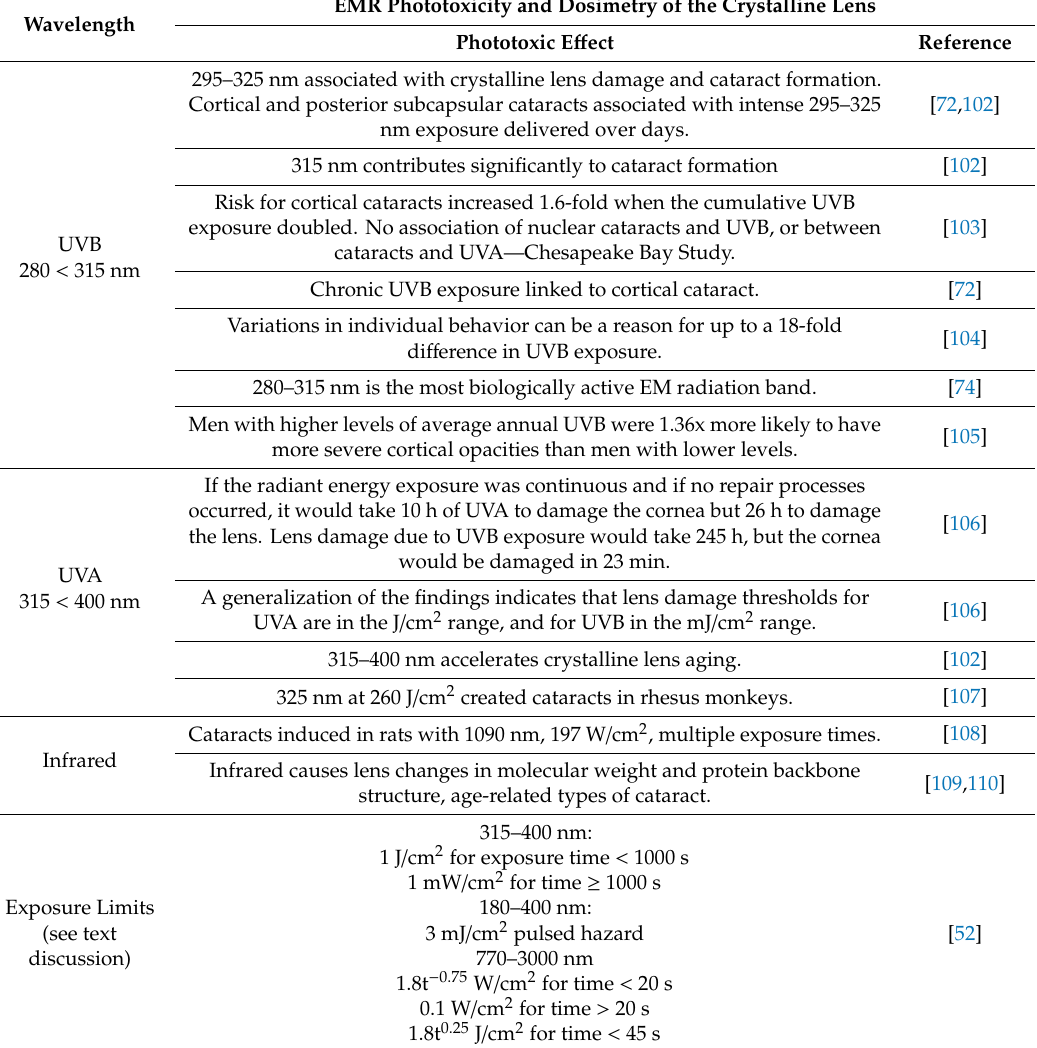
Table 4. Electromagnetic radiation action spectra and dosimetry thresholds for the crystalline